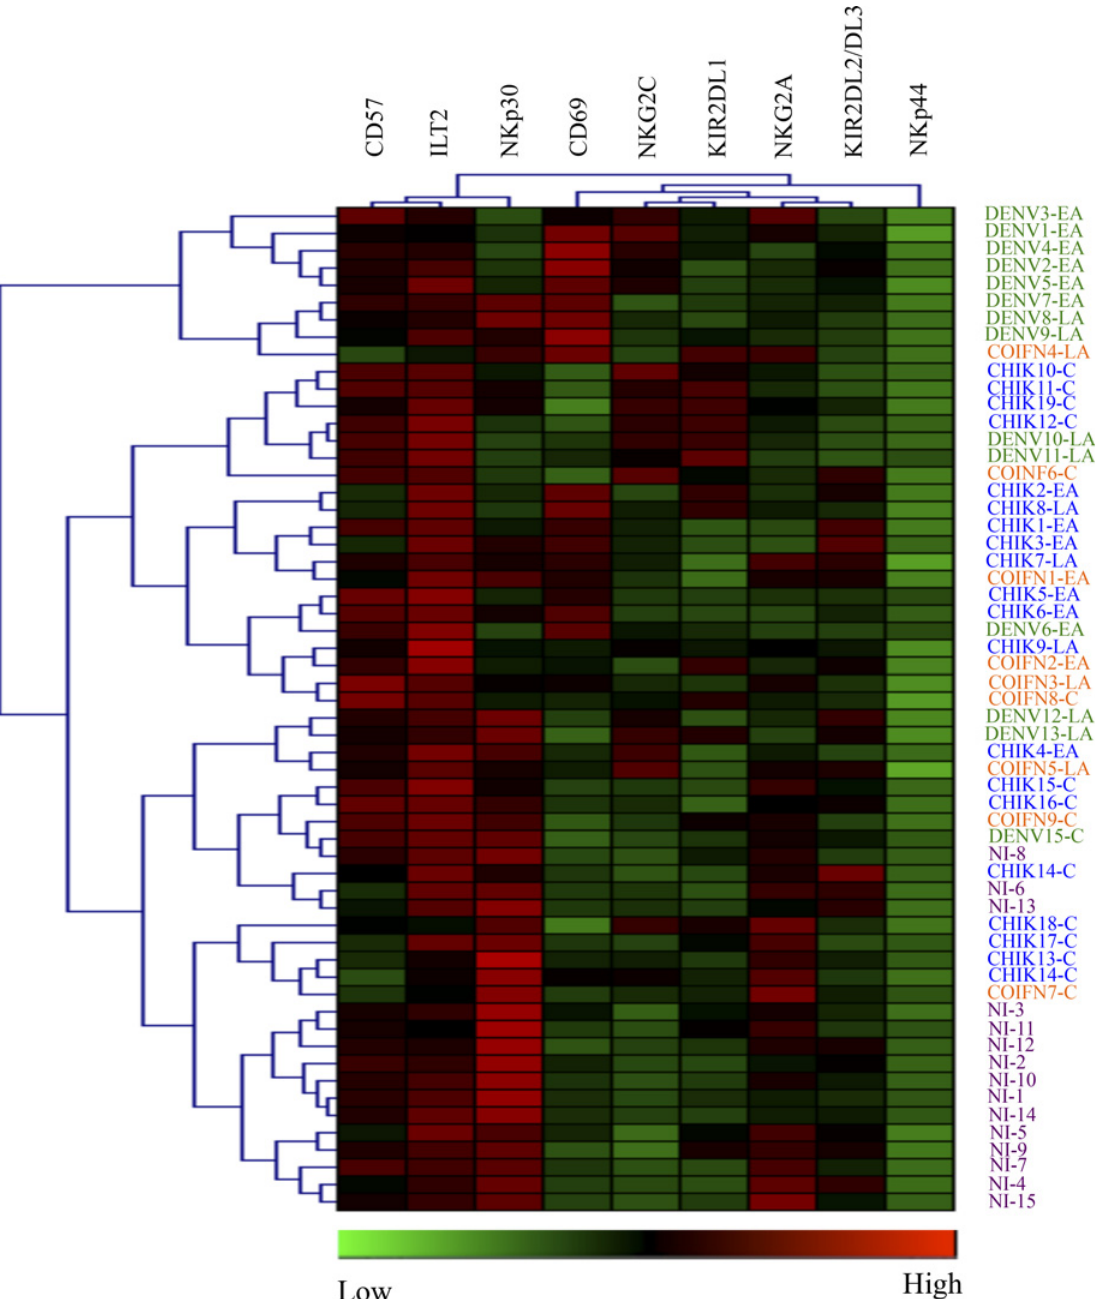
Fig 4. Hierarchical clustering analysis of 9 NK-cell markers from patients infected with DENV-2 (DENV; Green; n = 15), CHIKV (CHIK; Blue; n = 19), co-infected with CHIKV and DENV-2 (COIFN; Orange; n = 9), and non-infected healthy Gabonese controls (NI; Purple; N = 15). Patients were sampled in early acute (EA; day (D)0-D3), late acute (LA; D12-D15) and convalescent (C; D > 30) stages post-onset of symptoms. Hierarchical clustering analysis was performed with the Genesis program (software available at www.genome.tugraz.at), as previously described [14,25]. Each column is dedicated to a definite NK marker. The color of each square reflects the percentage of expression of the corresponding marker in each individual. The values measured for samples were color displayed and rank ordered considering the healthy donors ’ median as a reference: green color indicates inferior to median, and red color indicates superior to median, with values ranging from -3 to